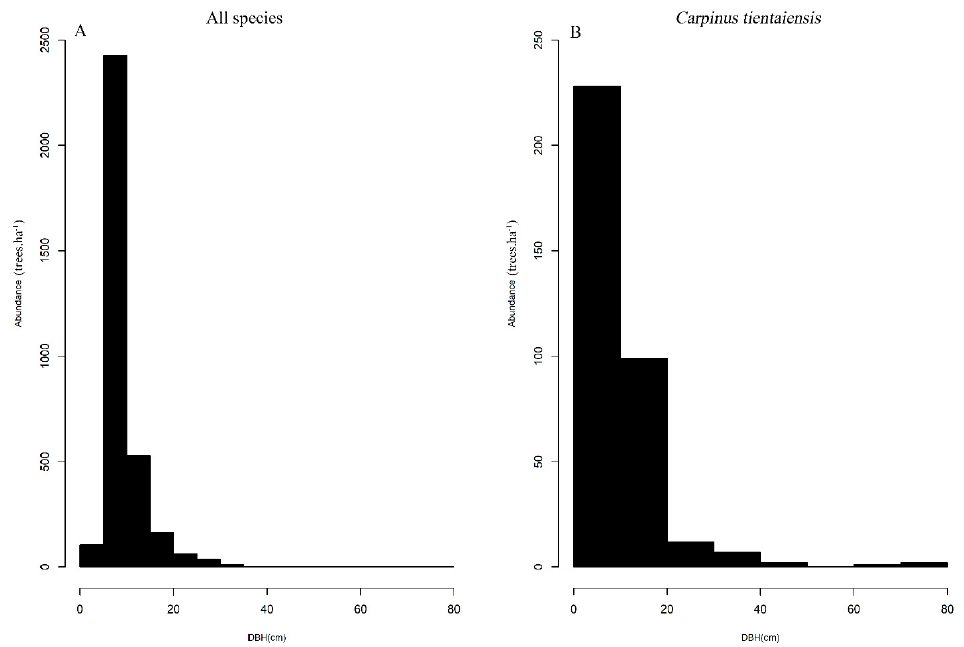
Figure 1. Diameter at breast height (DBH) structure of all species ( A ) and Carpinus tientaiensis ( B ).